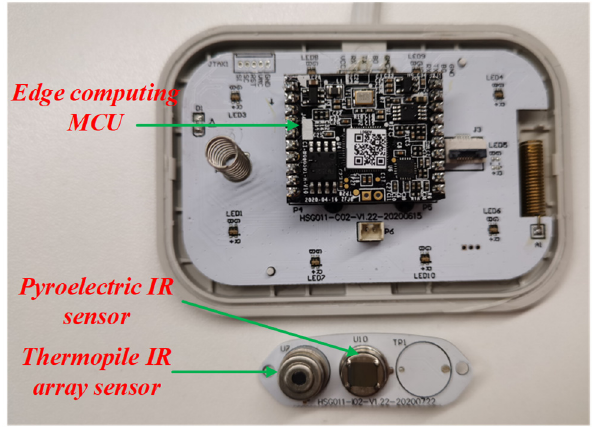
Figure 2. Fall detector based on a MEMS IR sensor and a PIR sensor.